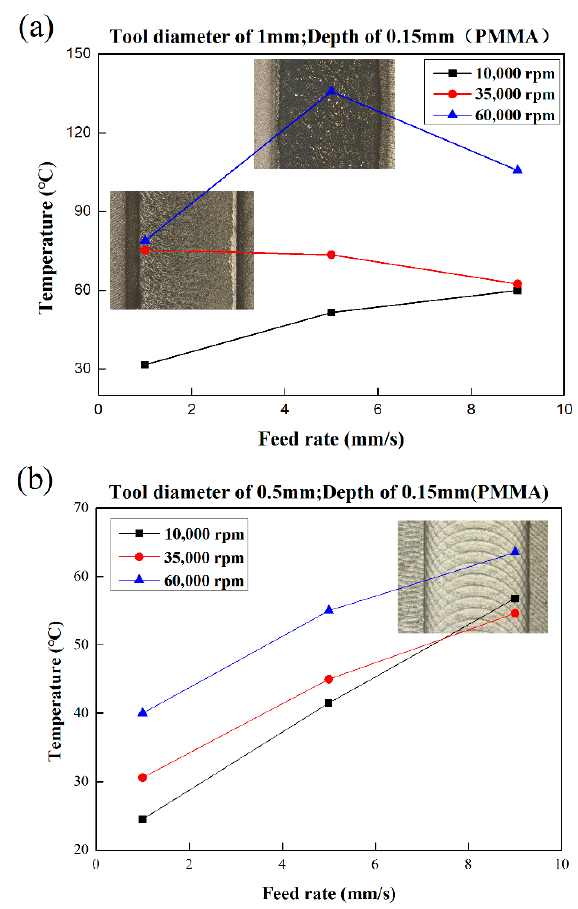
Figure 4. Bottom morphology of PMMA at various process parameters: ( a ) tool diameter 1 mm; ( b ) tool diameter 0.5 mm.